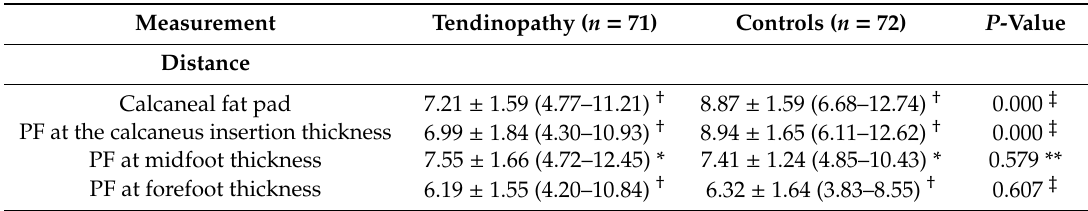
Table 2. Ultrasonography measurements.